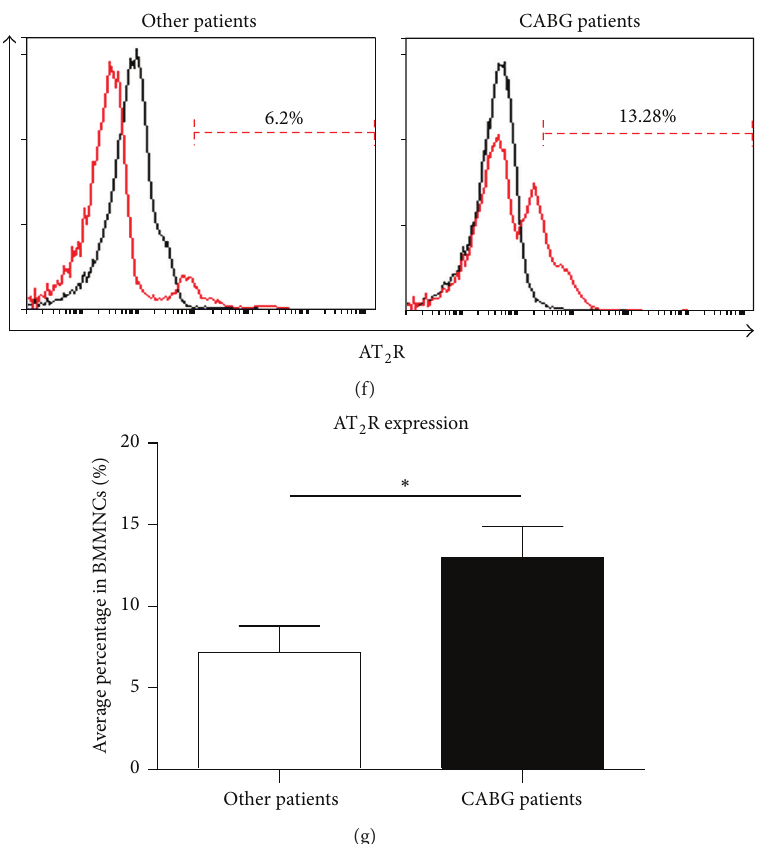
Figure 1: Flow cytometric analysis of BMMNCs. (a) FACS plots of c-kit + AT 2 R + , sca-1 + AT 2 R + , and CD34 + AT 2 R + cells isolated from MI and sham mice. (b) FACS plots were quantified as a percentage of AT 2 R + cells in total BMMNCs ( ∗ 𝑝 < 0.05, ∗∗ 𝑝 < 0.01 versus sham; values are means ± SEM; sham, 𝑛 = 6; MI, 𝑛 = 6). ((c)–(e)) Expression analysis of c-kit + AT 2 R + (c), sca-1 + AT 2 R + (d), and CD34 + AT 2 R + (e) in BMMNCs. Values are means ± SEM (sham, 𝑛 = 6; MI, 𝑛 = 6). (f) FACS plots of AT 2 R + cells isolated from human bone marrow. (g) Statistical expression analysis of AT 2 R + cells in total hBMMNCs ( ∗ 𝑝 < 0.05, versus other patients; values are means ± SEM (other patients, 𝑛 = 10; CABG patients, 𝑛 =